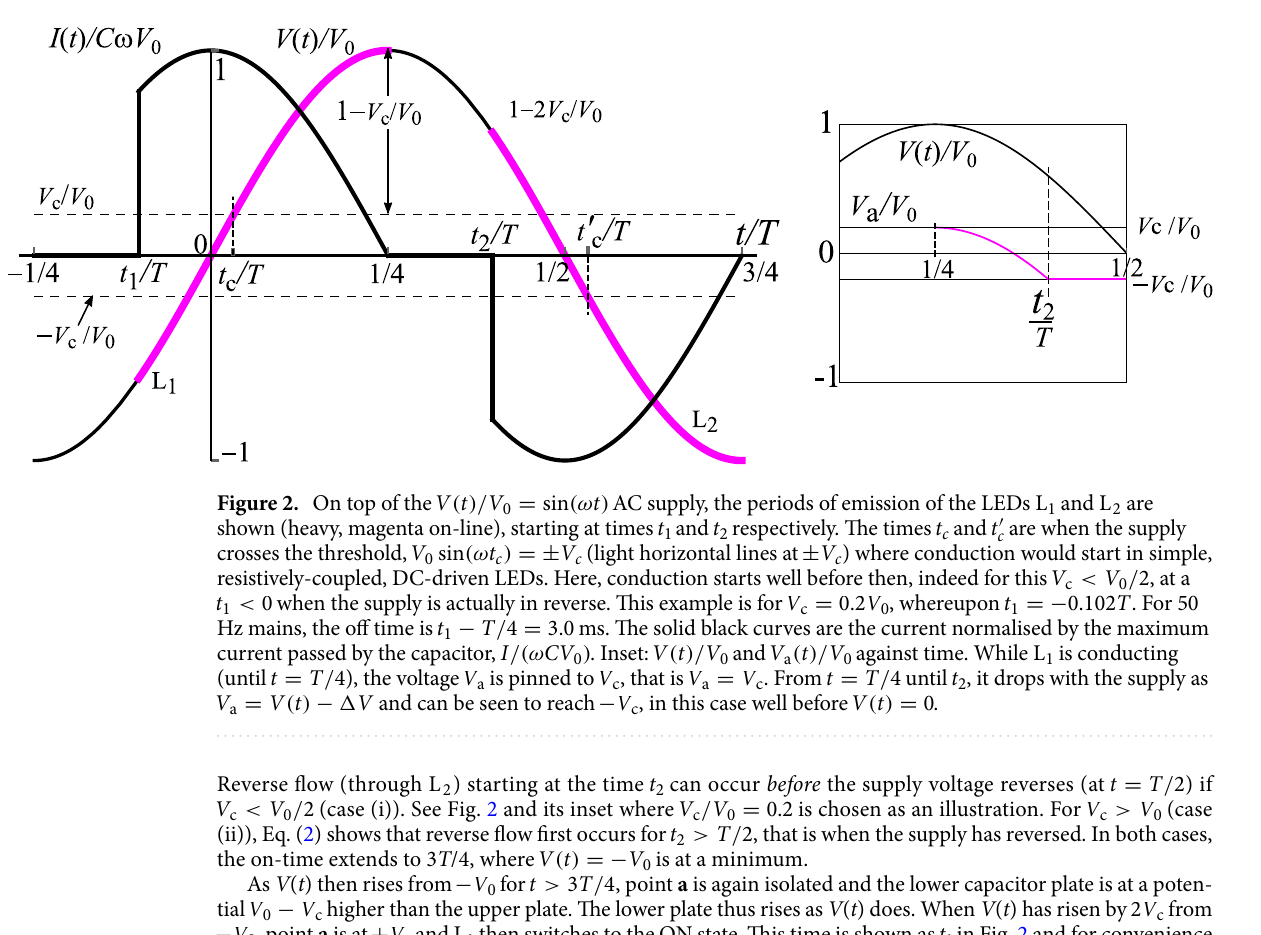
Reverse flow (through L 2 ) starting at the time t 2 can occur before the supply voltage reverses (at t = T / 2 ) if V c < V 0 / 2 (case (i)). See Fig. 2 and its inset where V c / V 0 = 0.2 is chosen as an illustration. For V c > V 0 (case (ii)), Eq. (2) shows that reverse flow first occurs for t 2 > T / 2 , that is when the supply has reversed. In both cases, the on-time extends to 3 T /4, where V ( t ) = − V 0 is at a minimum. As V ( t ) then rises from − V 0 for t > 3 T / 4 , point a is again isolated and the lower capacitor plate is at a poten- tial V 0 − V c higher than the upper plate. The lower plate thus rises as V ( t ) does. When V ( t ) has risen by 2 V c from − V 0 , point a is at + V c and L 1 then switches to the ON state. This time is shown as t 1 in Fig. 2 and for convenience depicted in the interval t > − T / 4 in this periodic scheme. The continuing response of L 1 is not like its initial switch-on we started with. For instance, it will switch on at a t 1 < 0 with V ( t ) < 0 for case (i).